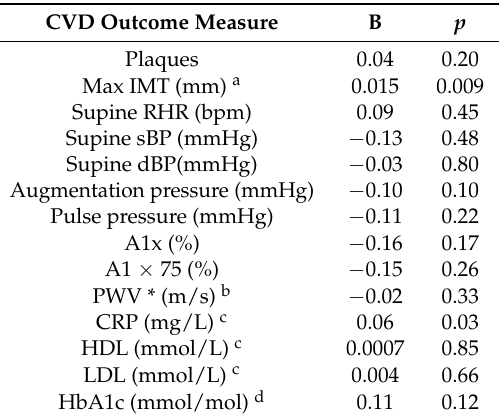
Table 4. The effect of number of years as shift worker on cardiovascular disease (CVD) risk factors. CVD Outcome Measure B p Plaques 0.04 0.20 Max IMT (mm) a 0.015 0.009 Supine RHR (bpm) 0.09 0.45 Supine sBP (mmHg) − 0.13 0.48 Supine dBP(mmHg) − 0.03 0.80 Augmentation pressure (mmHg) − 0.10 0.10 Pulse pressure (mmHg)